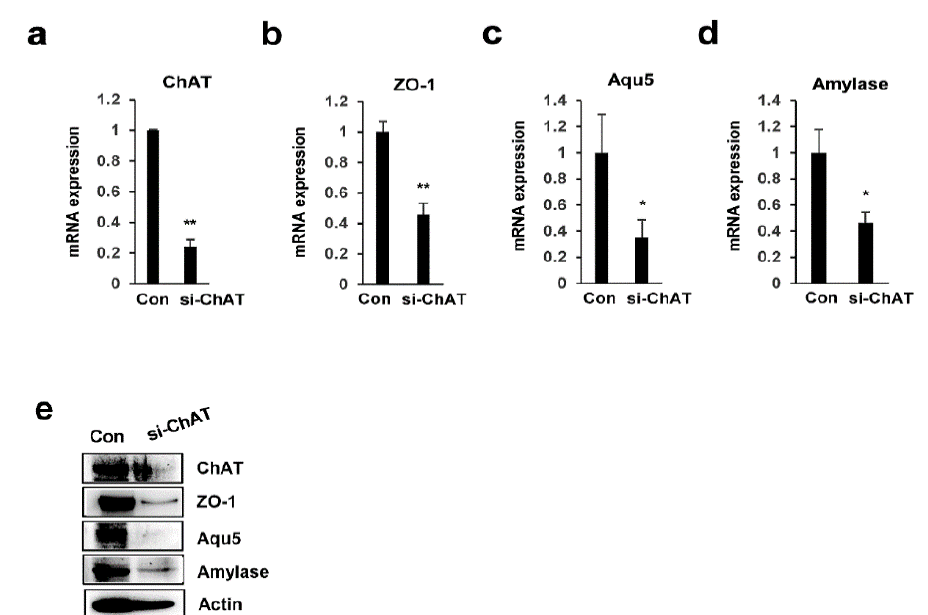
Figure 5. ChAT depletion diminished salivary gland functional marker expression. ( a – e ) PSGC kl +/+ cells were transfected with 1 nm of ChAT-specific siRNA (siChAT) for 48 h. Total mRNA and protein were extracted, and ChAT and salivary gland functional marker expression levels were evaluated by qRT-PCR and ChAT. Data are presented as the mean ± SD. * p < 0.05, ** p < 0.01.